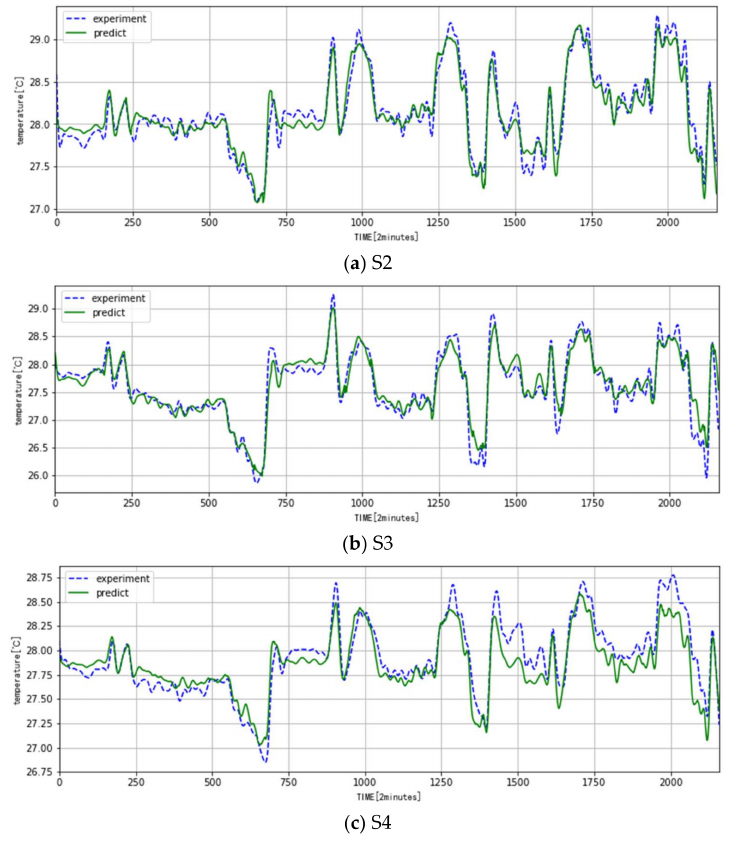
Figure 7. Comparison of predicted data with experimental data.